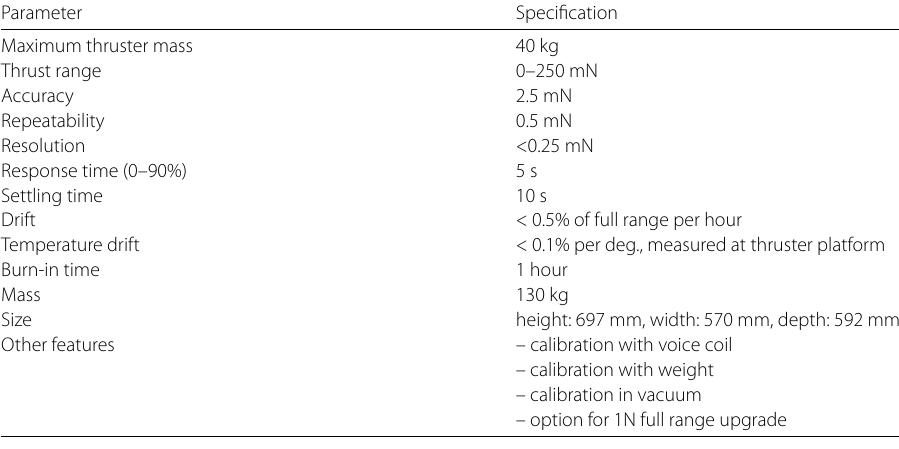
Table 2 Thrust balance design specifications, as given by manufacturer AST Parameter